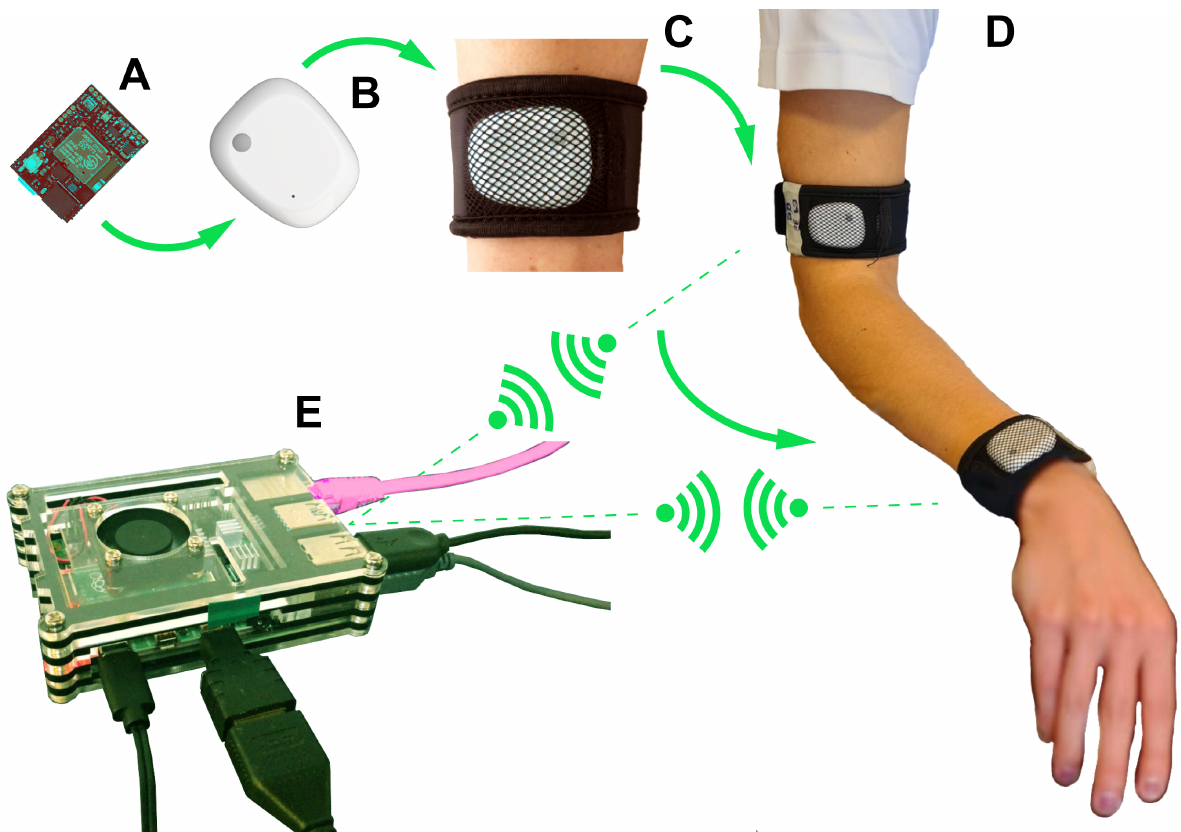
Figure 3. Wearable sensors system for motion assessment installation procedure: MetaMotionR (MMR) sensors boards ( A ) were put inside the cases ( A → B ); the cases were put in the velcro bands ( B → C ); the bands were placed as shown in ( D ); than the software on the Raspberry Gateway was run to collect data from sensors ( E